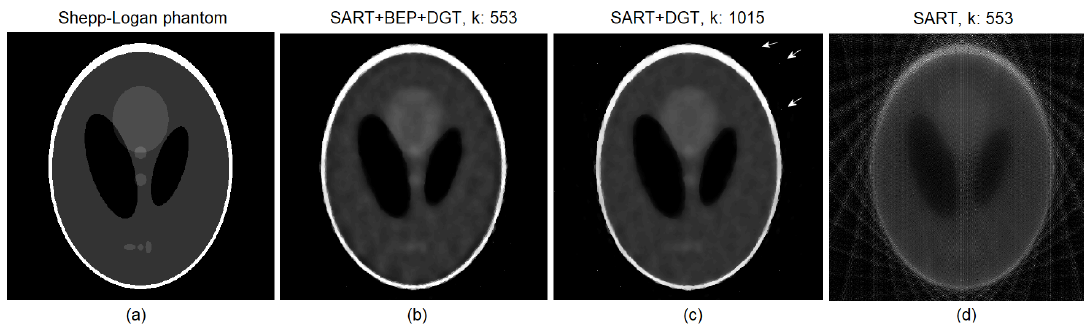
( b ) from SART+BEP+DGT with k = 553 steps, PSNR: 72.7103, SSIM: 0.9240, ( c ) from SART+DGT with k = 1015 steps, PSNR: 72.7103, SSIM: 0.8920, and ( d ) from pure SART with k = 553 steps, PSNR: 63.4625, SSIM: 0.1662. All with SNR = 60